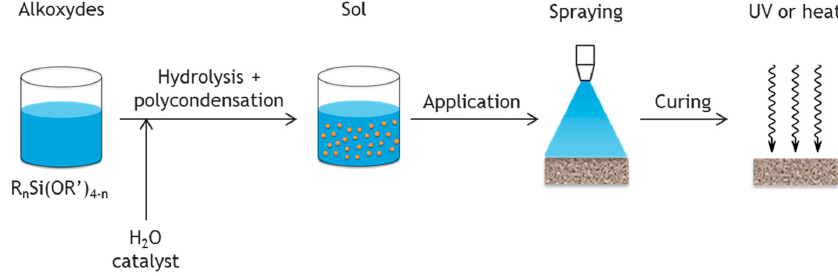
Figure 1. Coating procedure.